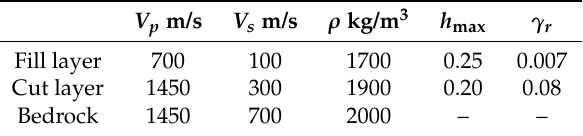
Table 1. Material properties (standard case). Here, V p , V s , ρ , h max , and γ r , indicate primary wave velocity, secondary wave velocity, density, maximum damping, and reference strain,